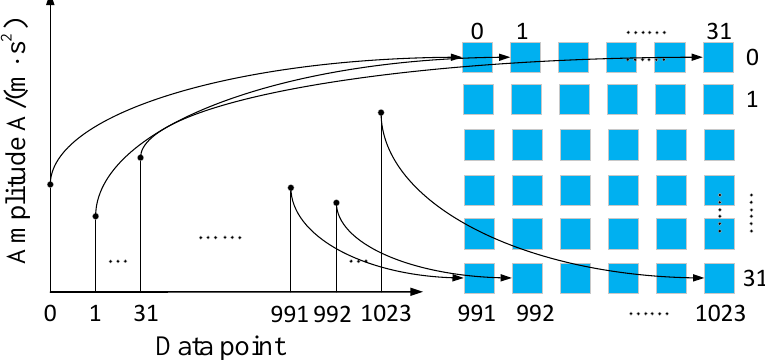
Figure 5. A brief illustration of